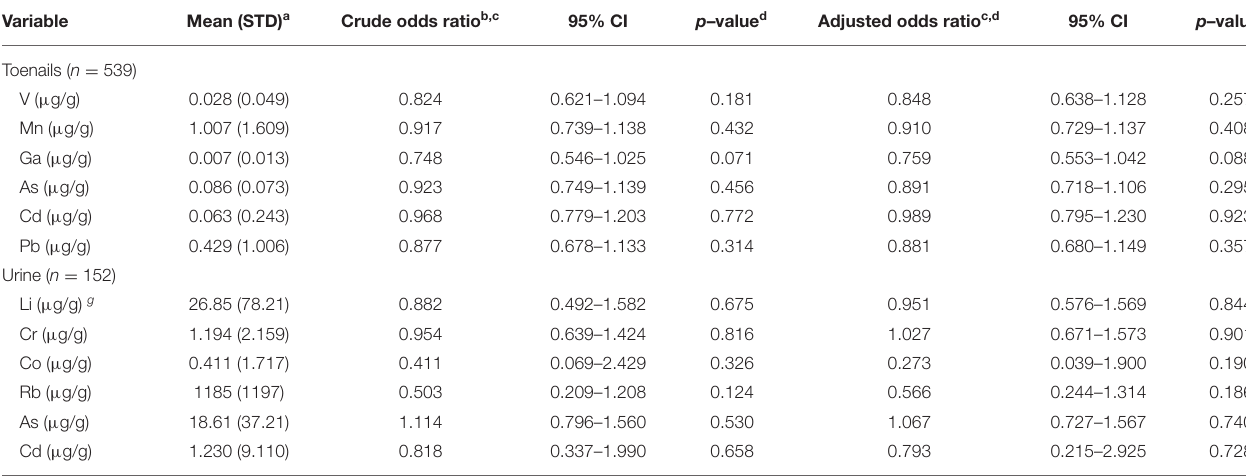
TABLE 5 | Association between prostate cancer and selected metal concentrations in toenail and urine samples. Variable